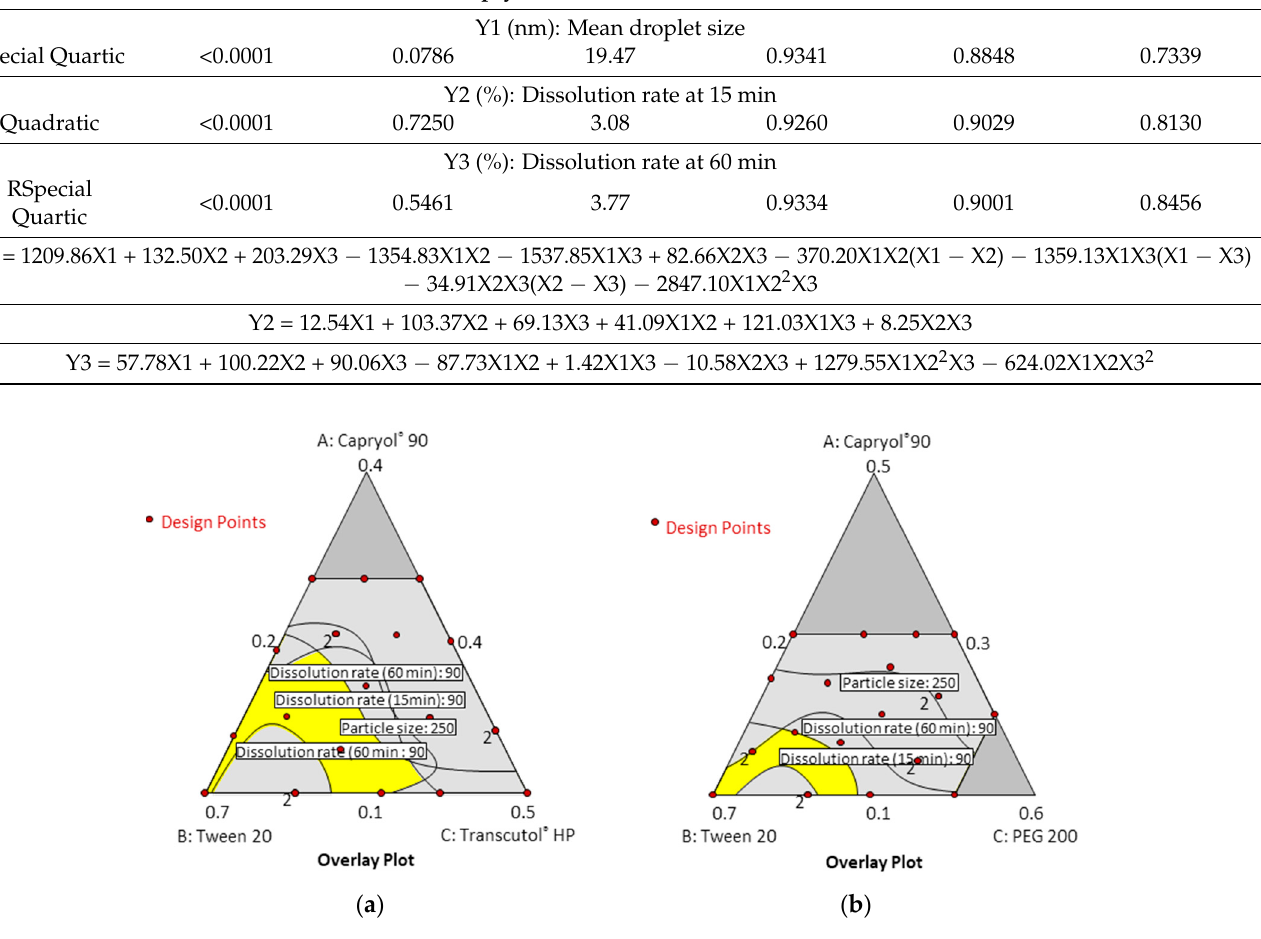
Figure 5. Overlay plot for the three response variables: ( a ) Capryol ® 90 (X1)/Tween 20 (X2)/Transcutol ® HP (X3); ( b ) Capryol ® 90 (X1)/Tween 20 (X2)/PEG 200 (X3). Table 3. Summary of the results of statistical analysis and model equations for measured response for D ‐ optimal mixture design.